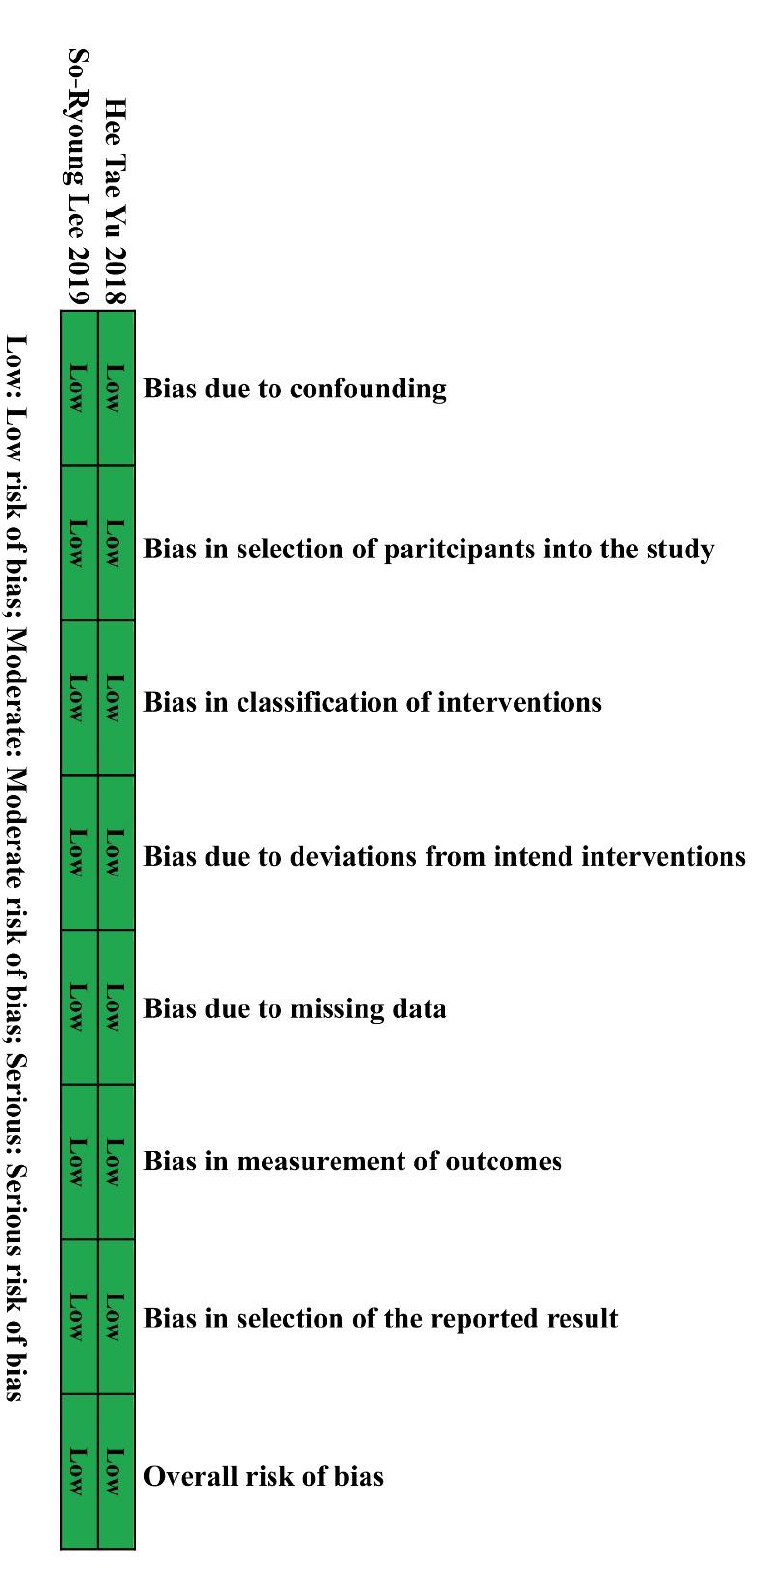
Figure 4. Summary of each retrospective study evaluated using ROBINS-I.